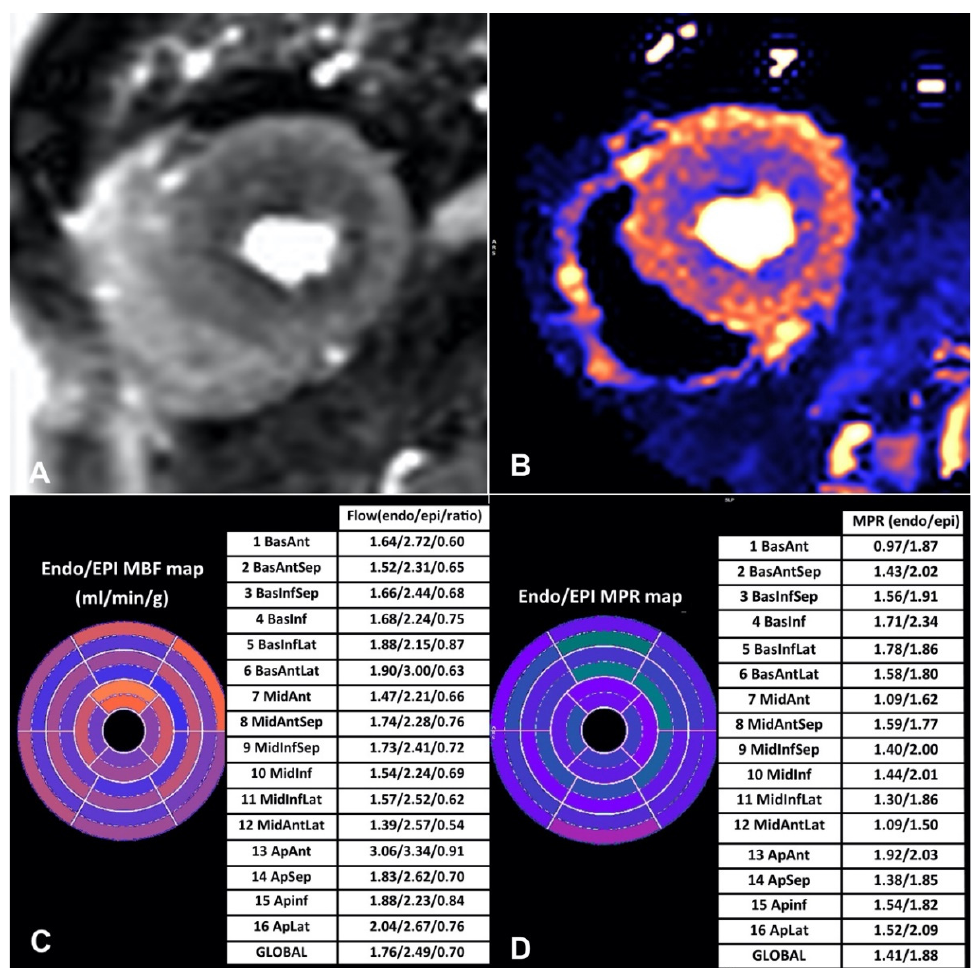
Figure 2. Visual and quantitative stress myocardial perfusion analysis in a patient with microvascular dysfunction. ( A ) First-pass perfusion images showing a circumferential hypointense area in the endocardium. ( B ) Pixel-wise map of myocardial blood flow map demonstrating the regions of low flow in darker color than normal flow. ( C , D ) Polar maps of myocardial blood flow (MBF) and myocardial perfusion reserve (MPR) demonstrating low values in the endocardium compared to normal values in the epicardial segments.